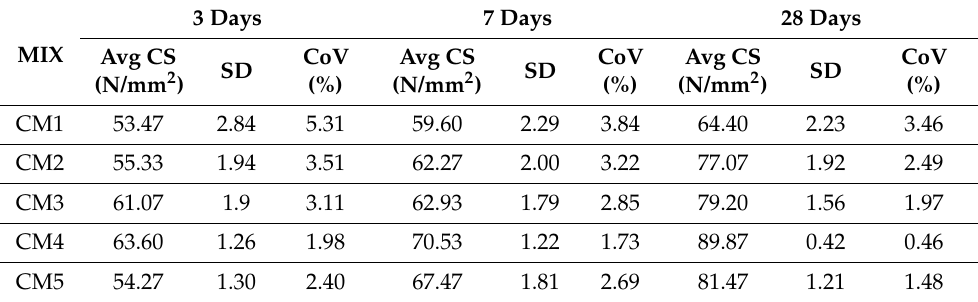
Table 3. Compressive strength of